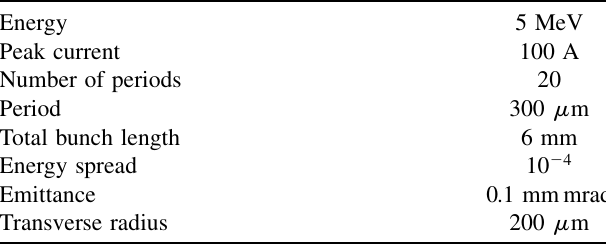
TABLE I. Parameters for coasting beam